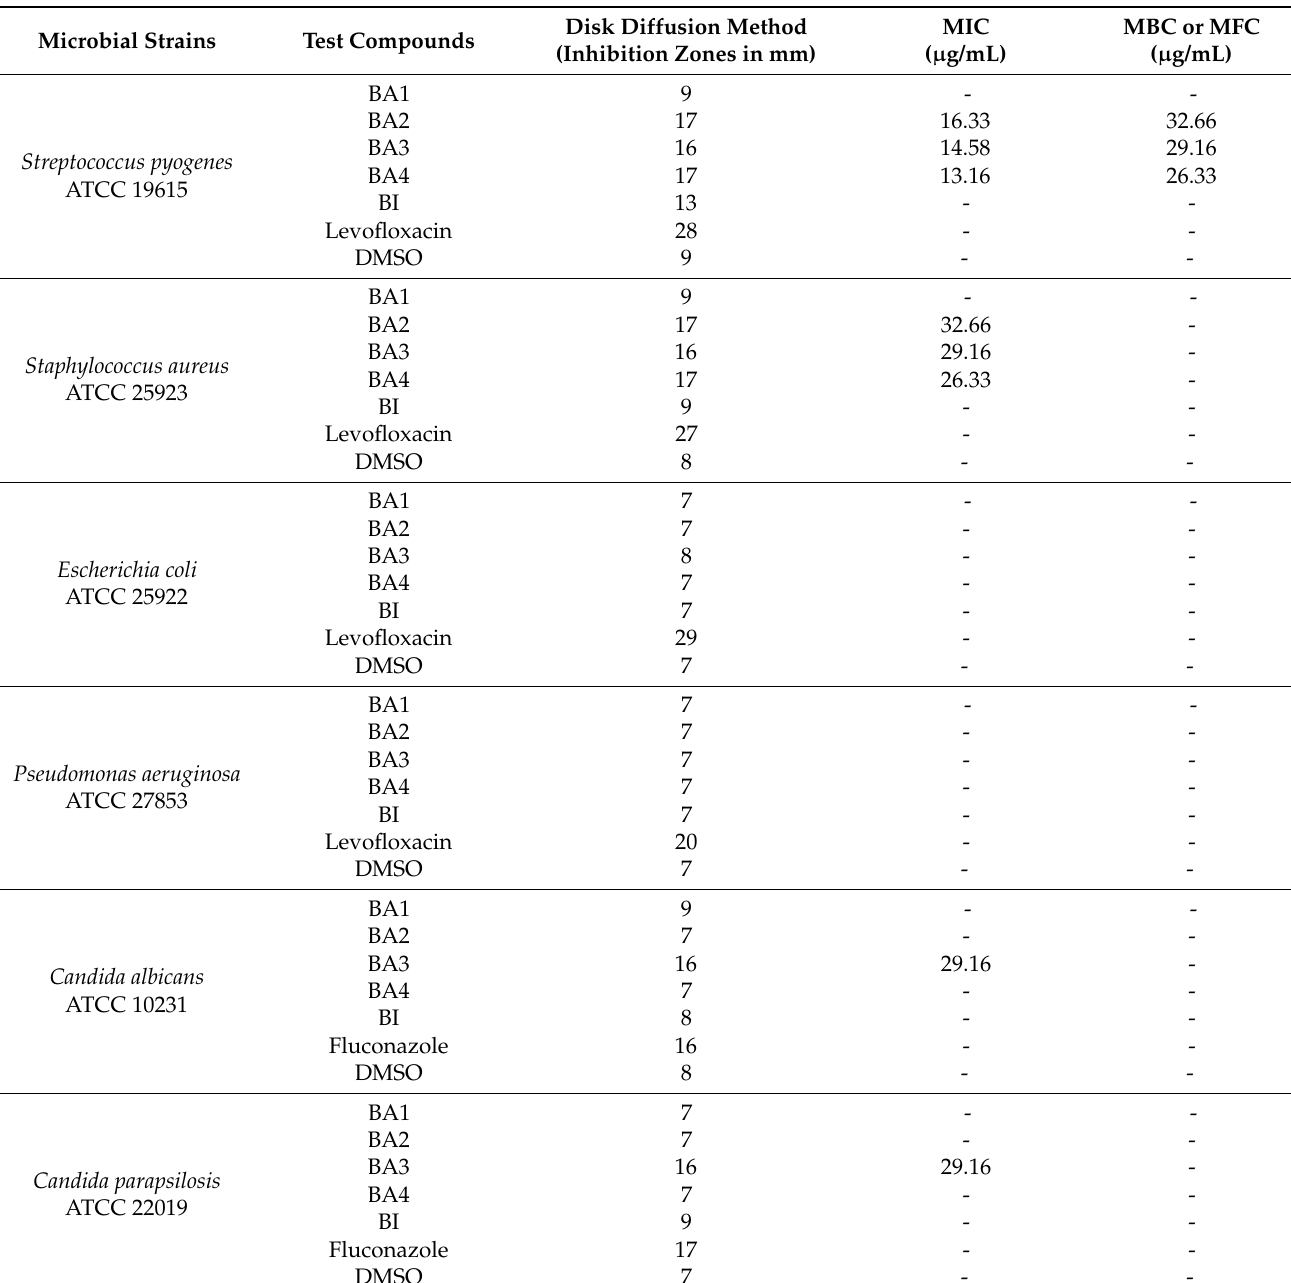
Table 2. The diameter of the zone of inhibition, minimum inhibitory concentration, and minimum bactericidal concentration of betulinic acid and 2,3-indolo-betulinic acid derivatives for the investi- gated